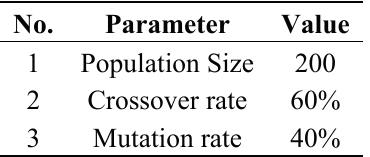
Table 5. The parameters of Genetic Algorithm (GA).